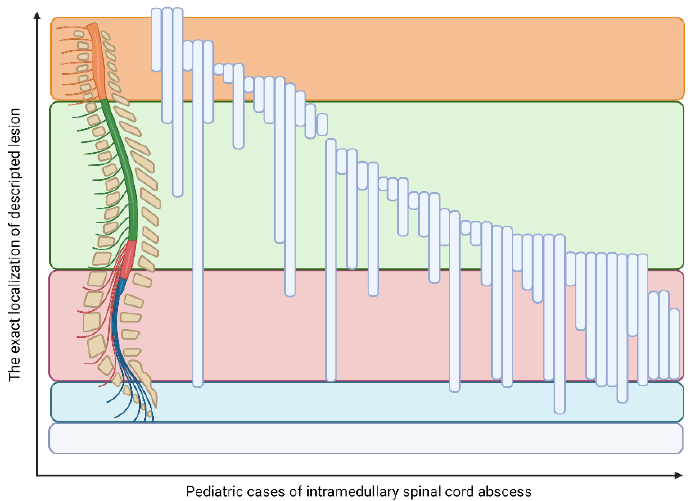
Figure 4. The localization of the intramedullary spinal cord abscess in children.